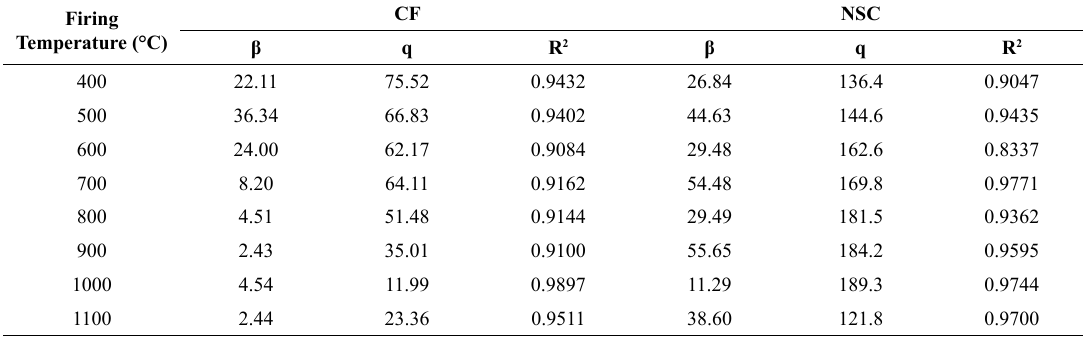
Table 2. Weibull parameters for the water absorption of clay fraction (CF) and natural silty clay (NSC) fired at different temperatures. Firing Temperature